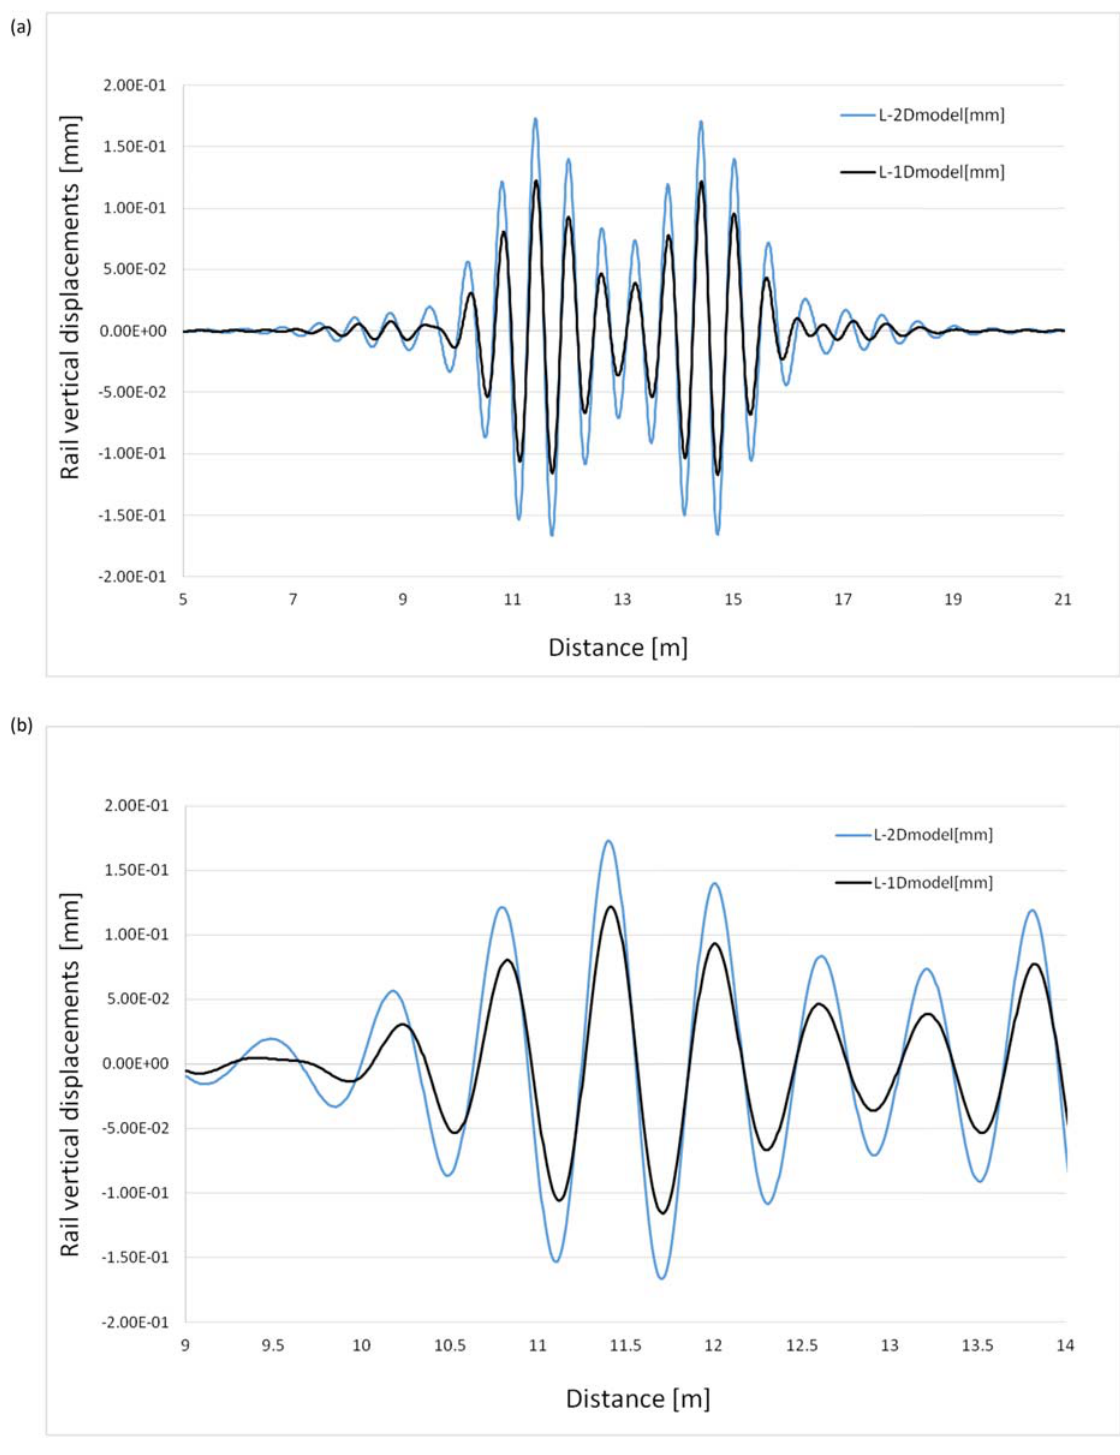
Figure 4: ( a ) The whole rail displacements for a two - layer ( L - 2D model ) and a one - layer ( L - 1D model ) models ( Thalys train, v = 200 km/h, k = 91.1 MPa, imperfection s = 10 μ m, and L r